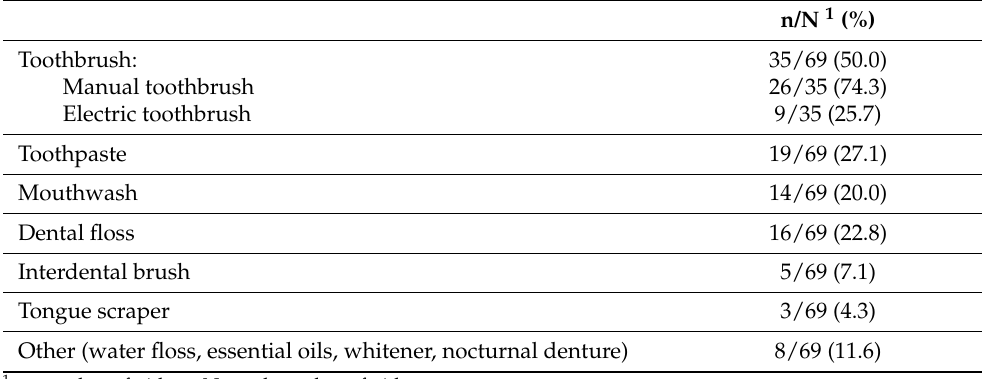
Table 2. Oral care products used in the TikTok videos corresponding to